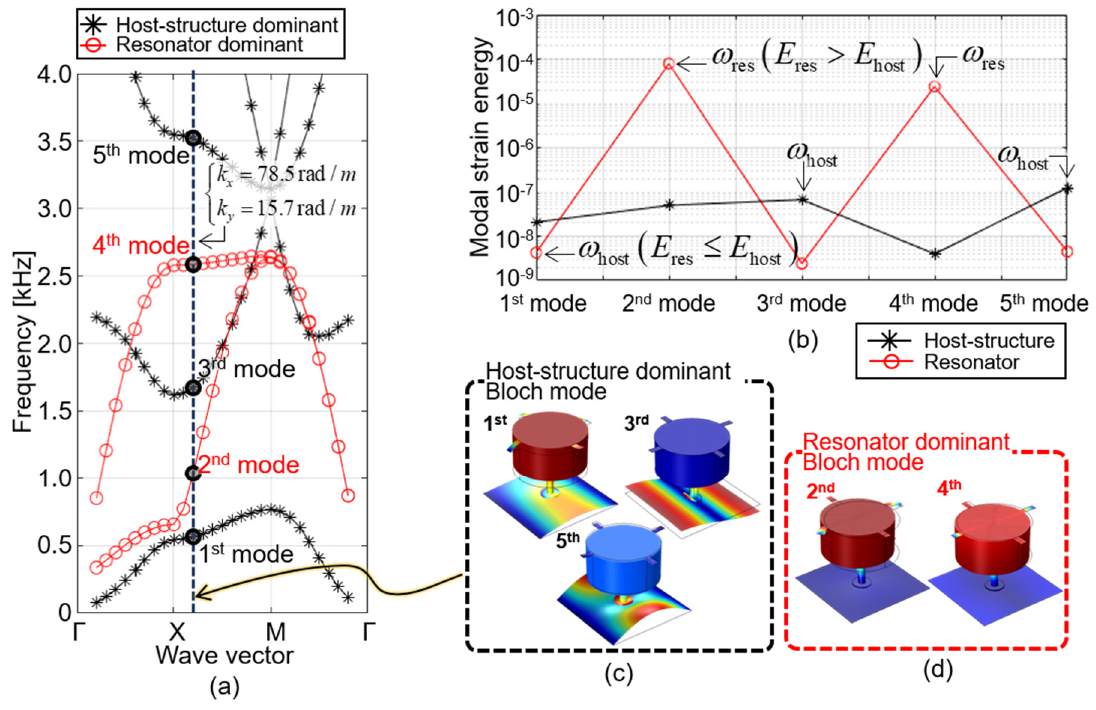
Figure A1. Schematic diagram of the separation of the host-structure- and resonator-dominant Bloch modes: ( a ) stopband plot of the interconnected metamaterial; mode shape of ( b ) the host-structure-dominant Bloch mode, ω host ; ( c ) the resonator dominant Bloch mode, ω res ; and ( d ) modal strain energy calculated in the host structure/resonator domain for each mode at the wave vectors of k x = 78.5 rad / m and k y = 15.7 rad / m